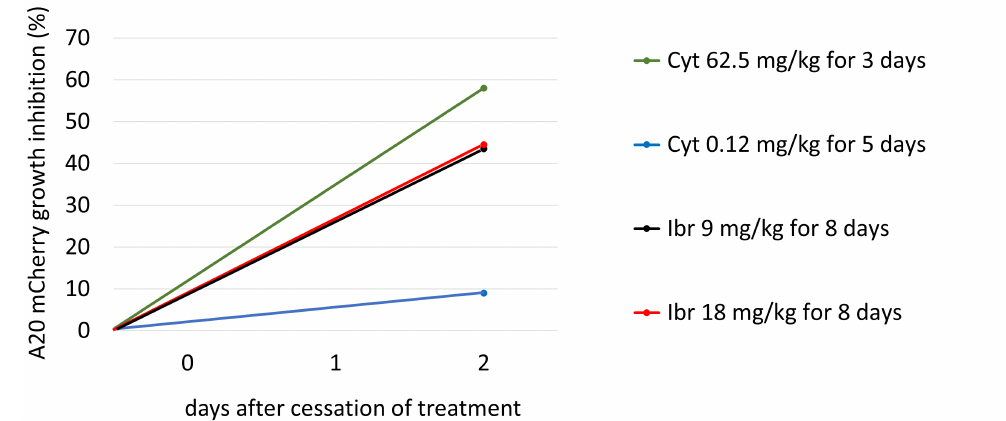
Figure 3. The growth inhibition of A20 mCherry cells in vivo under the influence of different treatment protocols. On day 22th, after A20 inoculation, blood was taken from the tail vein of each mouse, and A20 cells were measured as described above. Cyt Low group (blue bar) received 0.12 mg/kg of Cyt for 5 consecutive days; Cyt High group (green bar) received 62.5 mg/kg of Cyt for 3 consecutive days; Ibr Low (black bar) and Ibr High (red bar) groups received 9mg/kg and 18 mg/kg of Ibr, respectively, on days 1–5 and 8–10 from the beginning of the treatment. Blood was collected from the tail vein on Day 12 after the beginning of treatment from all mice. The frequency of A20 was measured using flow cytometry, as described above. The difference between the average frequency in each test group and the untreated Control group equals percent growth inhibition as a function of